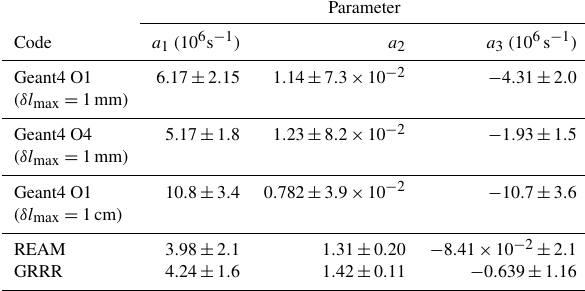
Table 2. Values of the parameters of the fits (with 95% confidence intervals) for the electron mean energies using Eq. (20). F is set to 0.28MeVm − 1 . The corresponding curves are shown in Fig.